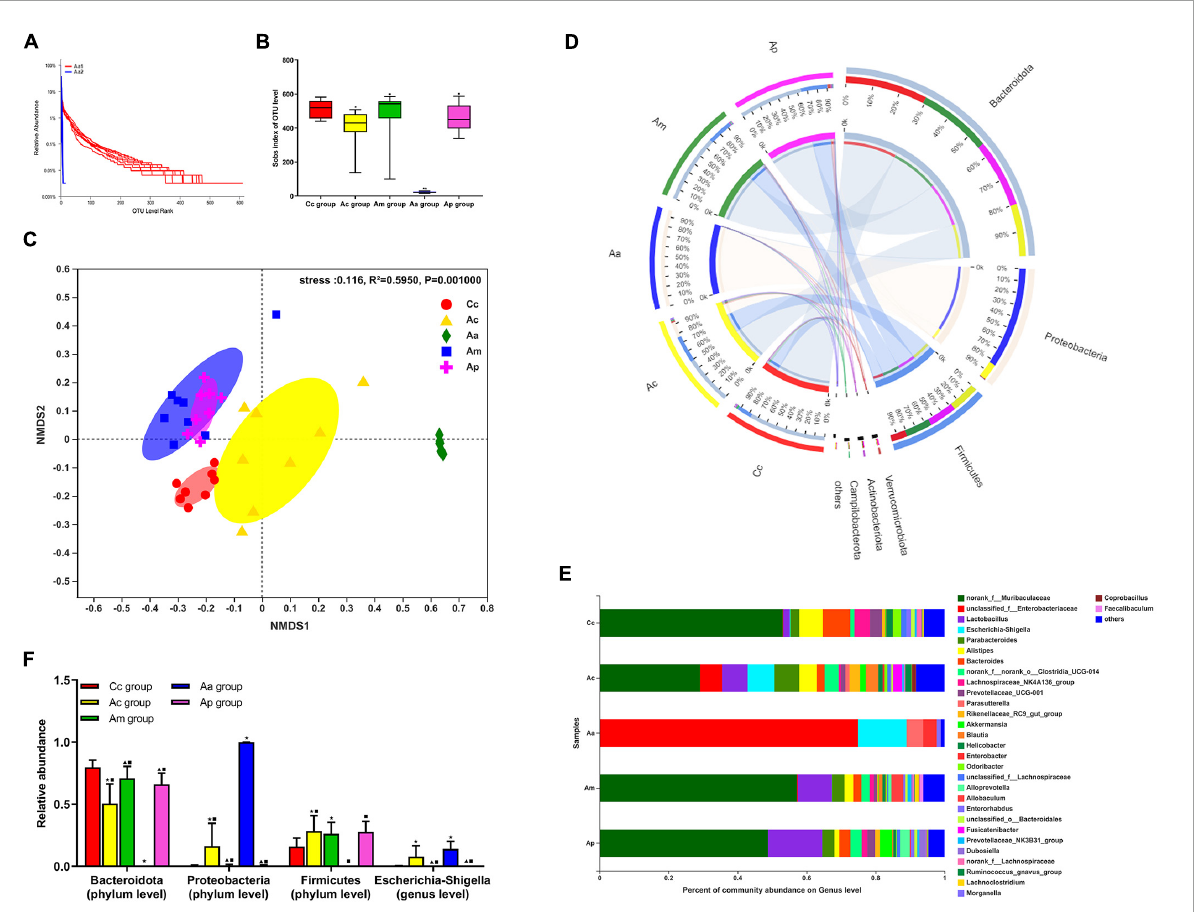
FIGURE2 Results of the 16S rRNA in each group ( n = 10, mean ± SD). (A) Rank abundance curves in the APP/PS1 antibiotic + manual acupuncture (Aa) group on day 1 (before antibiotic pretreatment, Aa 1) and day 7 (after antibiotic pretreatment, Aa 2). (B) α -Diversity analysis of fecal microbiota by the Sobs index. (C) β -Diversity analysis of fecal microbiota by NMDS. (D–F) Microbial relative abundance at the phylum and genus levels. The Kruskal–Wallis test was used. Chi-square was presented in Supplementary Tables 2, 3 (cid:70) P < 0.01 or P < 0.05 compared with the C57BL/6 control (Cc) group, (cid:78) P < 0.01 or P < 0.05 compared with the APP/PS1 control (Ac) group, (cid:4) P < 0.01 or P < 0.05 compared with the APP/PS1 antibiotic + manual acupuncture (Aa)